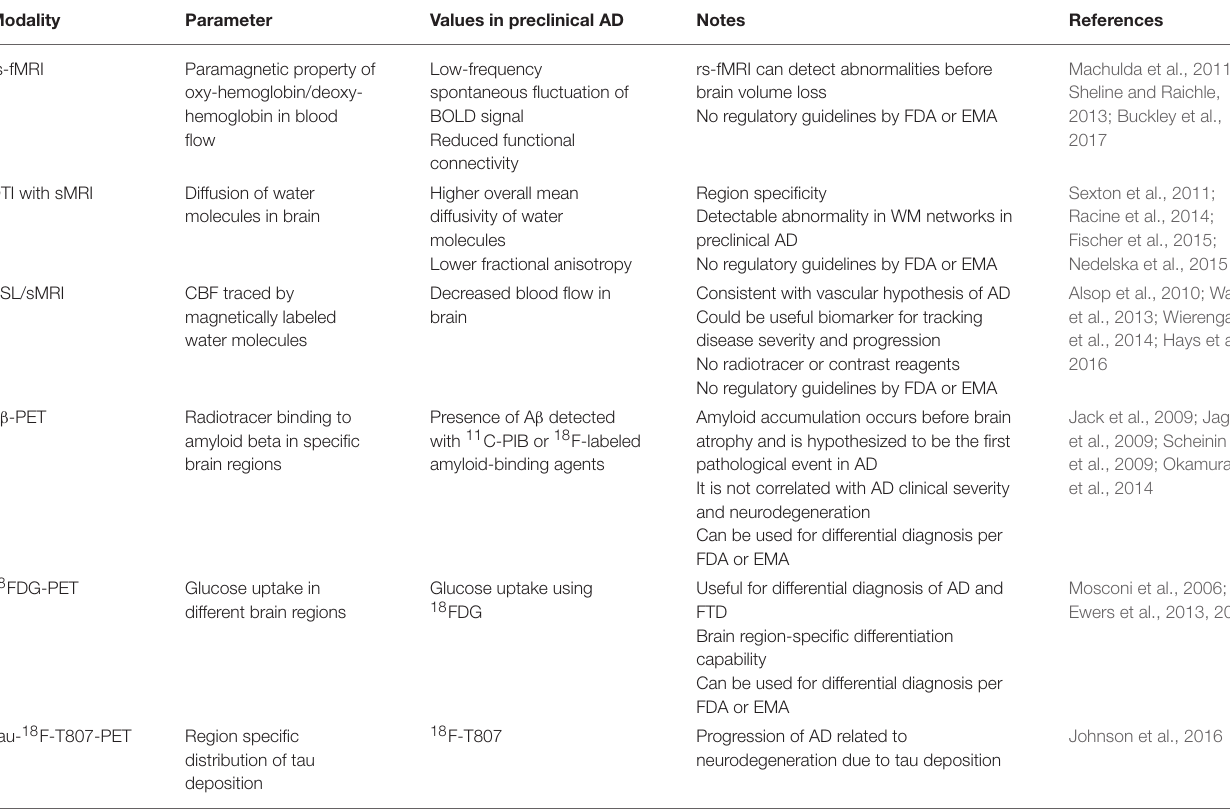
TABLE 2 | Preclinical Alzheimer’s disease neuroimaging